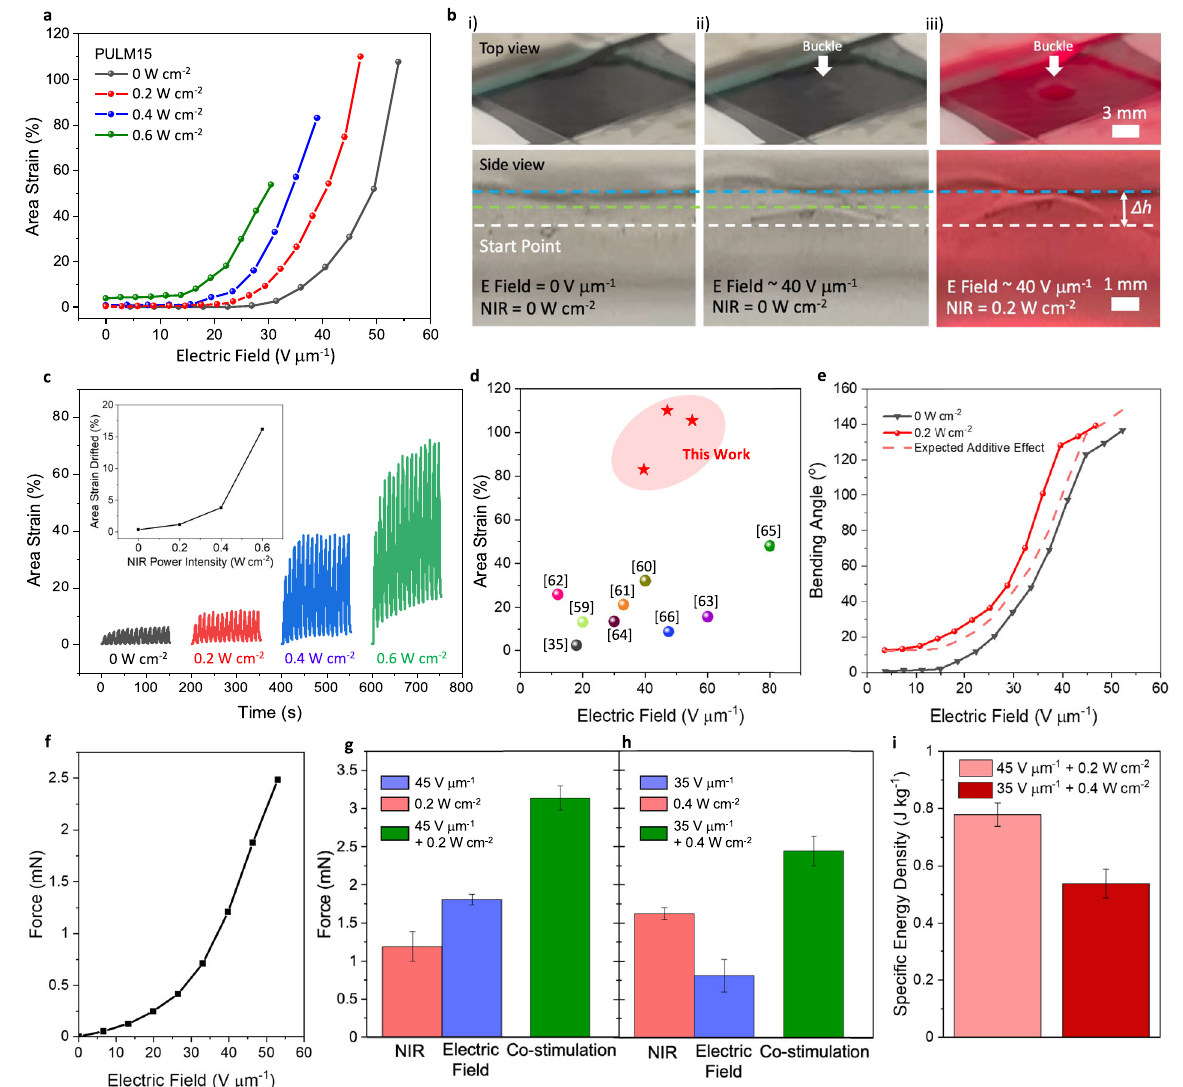
Fig. 5 | Co-stimulation of PULM15 DEA. a Representative area strains of PULM15 DEAs driven byelectric fi eld ( E fi eld) and NIR light. b Digitalimages oftop and side views of PULM15 DEA in the (i) original state (ii) solely driven by electric fi eld, and (iii) simultaneously driven by electric fi eld and NIR light. Dotted lines indicate the heightofout-of-planedisplacementsduringactuation. Δ h representsthechangein height between the original and co-stimulated state. c Cyclic actuation of PULM15 DEA being simultaneously driven by electric fi eld and NIR light at 0.1Hz. Inset shows the drifted area strains after 15 cycles as a function of NIR light intensity. d Ashby chart summarizing the area strains vs electric fi elds of DEAs that utilize fi llers. e Representative bending angles of PULM15 DEMES individually driven by electric fi eld and simultaneously driven by electric fi elds and NIR light intensity of